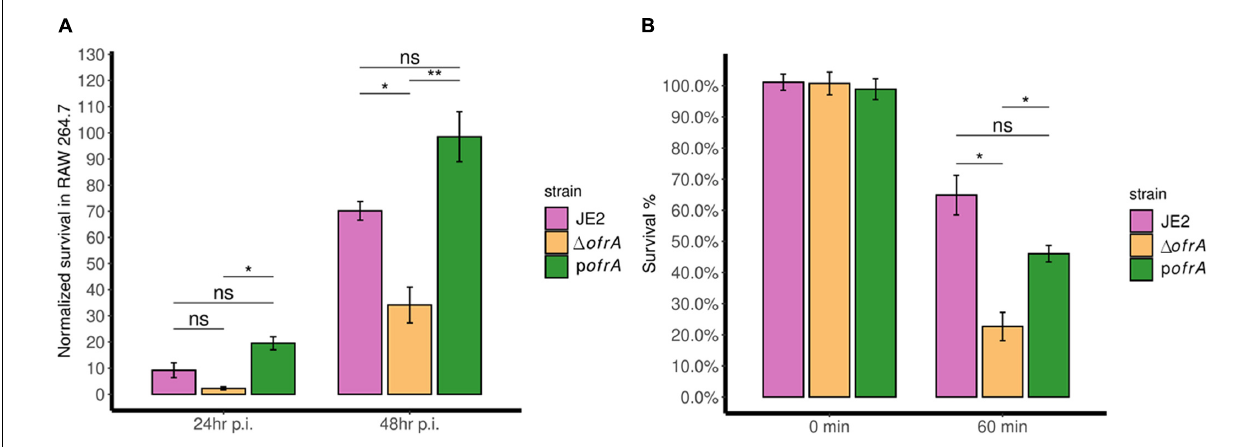
FIGURE 4 | OfrA promotes S. aureus fitness at the host-pathogen interface by enhancing survival in RAW 264.7 macrophages and whole human blood. (A) Macrophage survival assay. JE2, (cid:49) ofrA , and p ofrA were added to RAW 264.7 macrophage cell lines in 1:10 MOI. After 1 h of infection, gentamicin (150 µ g/ml) was used to kill extracellular bacteria for 1 h. Fresh RPMI + 10% FCS was added ( t = 0). At ( t = 4 h), viable intracellular bacteria were determined and the CFU/ml was used as a normalization factor. Samples were taken at ( t = 24 and 48 h). The assay was repeated for three independent experiments. Data represent five biological replicates from one of the three experiments. (B) Whole human blood killing assay. A total of 5 × 10 6 CFU/ml of each strain were incubated in whole human blood for 60 min at 37 ◦ C with continuous shaking. The number of viable bacteria was enumerated after serial dilutions in sterile 1 × PBS using SP-SDS method on LB agar and normalized to the viable cells without incubation. The experiment was repeated in blood taken from four different blood donors. Data represent four biological replicates from one of the four experiments. Error bars represent the standard error of the means. Statistical analysis was carried out using one-way ANOVA and pairwise t -test with Bonferroni correction p -value adjustment; ns, not significant; * p < 0.05; ** p <